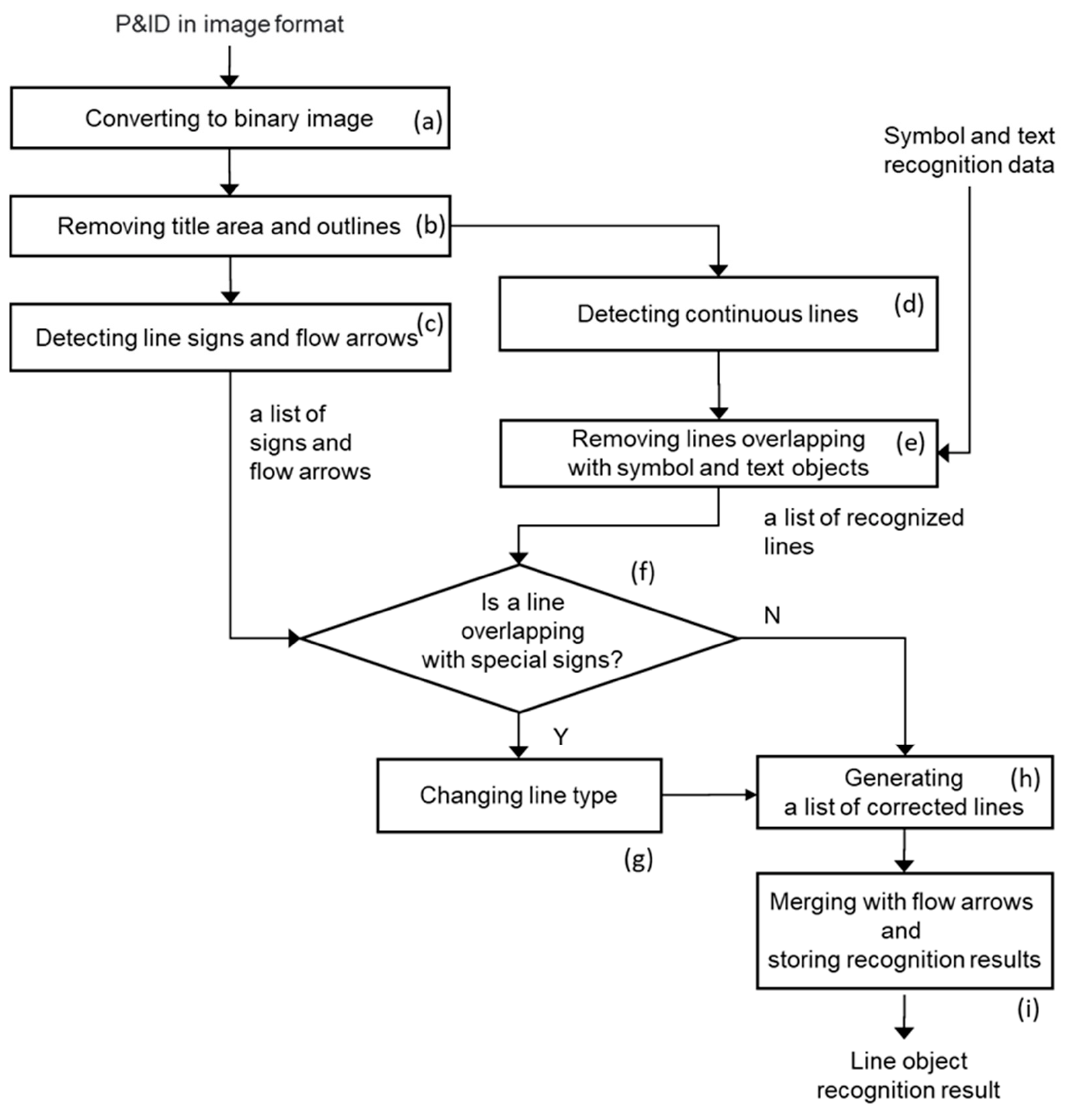
Figure 3. Procedure for recognizing line objects.